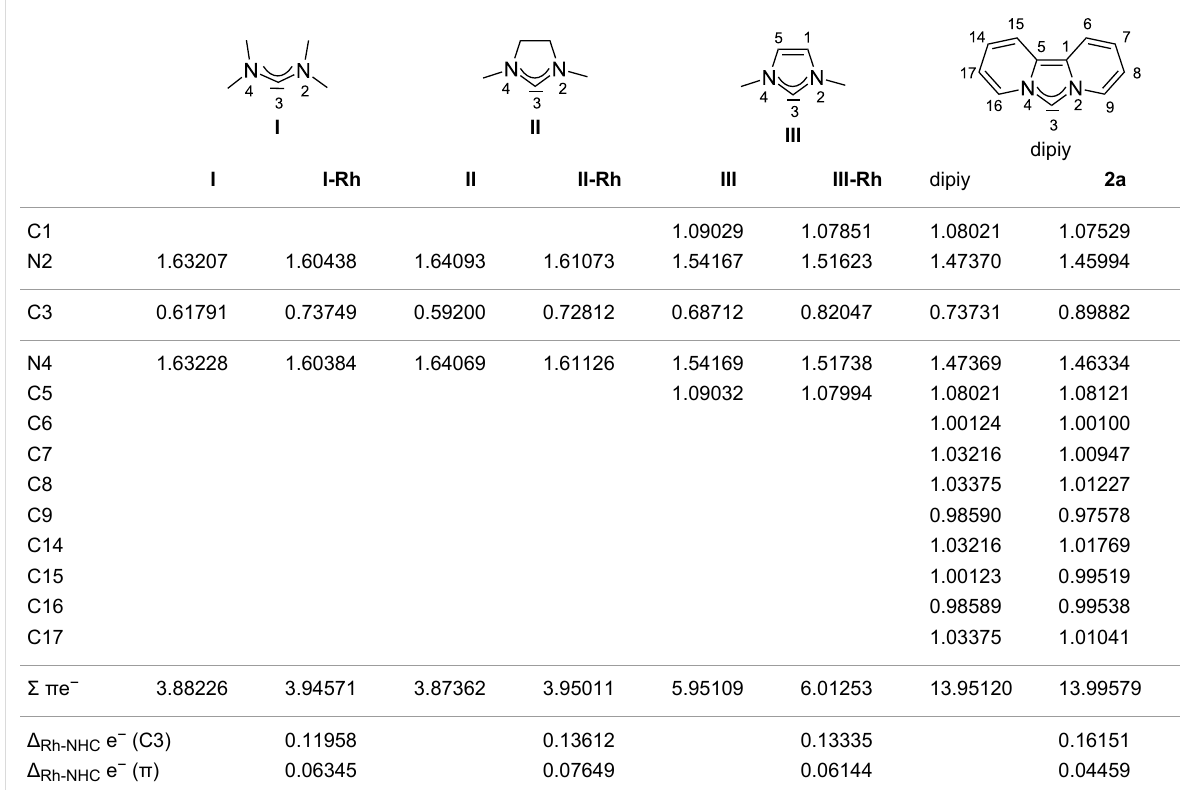
Table 3: Electron occupation (e − ) of the p π orbital at the carbene atom C3 and at the other atoms of the π -system in the free carbenes I–III and dipiy and in their Rh carbonyl complexes.